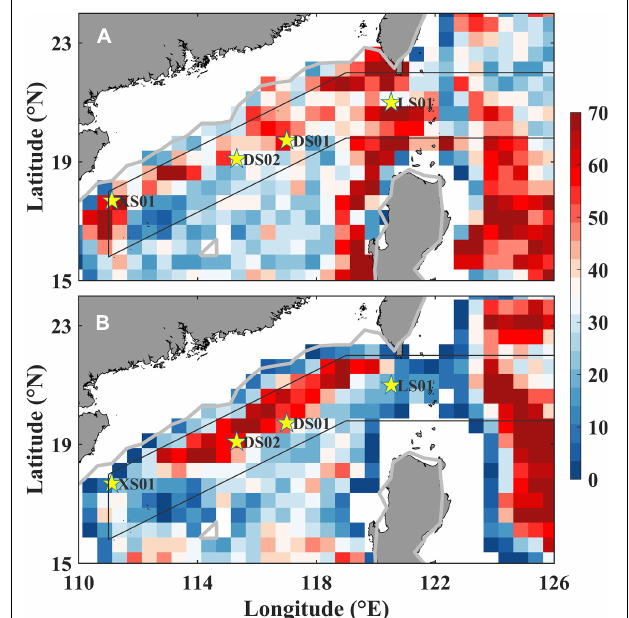
FIGURE 12 | (A) Mean eddy radius (km) and (B) mean eddy propagation speed (m/s) along with the black box of Figure 8 . Thin black lines: raw data; thick red lines: running means of raw data; mooring stations (yellow stars) are marked on lines according to longitudes; gray dashed boxes: Luzon Strait.